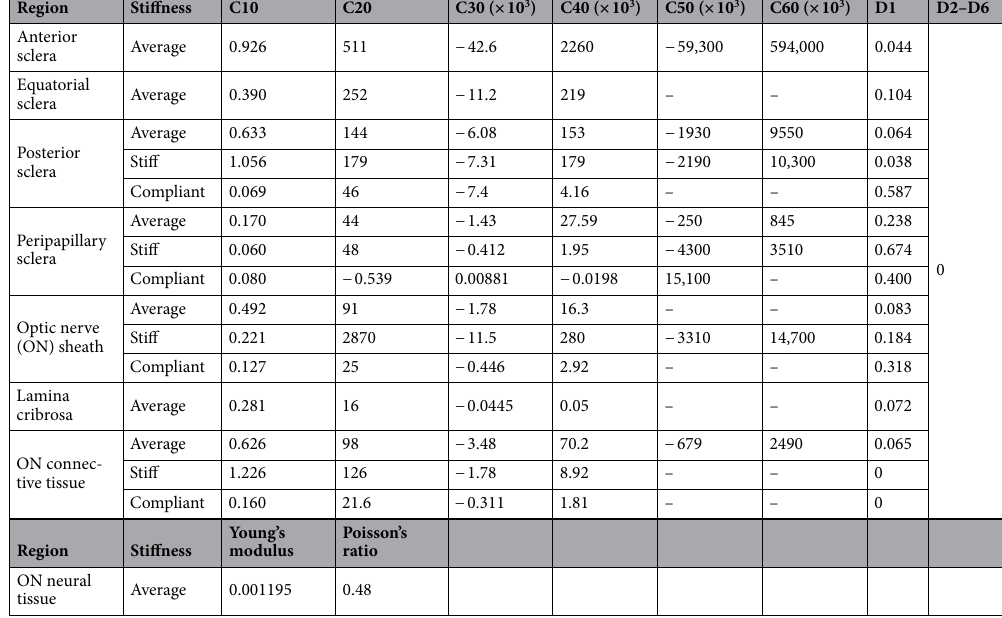
the model’s rigid anterior sclera in initial and tethered adducted positions (Fig. 3). In the simulation employing average tissue properties, the temporal LC edge shifted 418 μm nasally and 504 μm posteriorly during adduction tethering. Extreme case B had smaller LC displacement in both nasal-temporal (296 μm nasal) and anterior– posterior (488 μm posterior) directions than the average case (Fig. 3). Extreme cases C and D exhibited larger LC displacement nasally and posteriorly than the average case: there was 550 μm nasal and 559 μm posterior shift in case C, and 233 μm and 585 μm shift in case D, respectively.